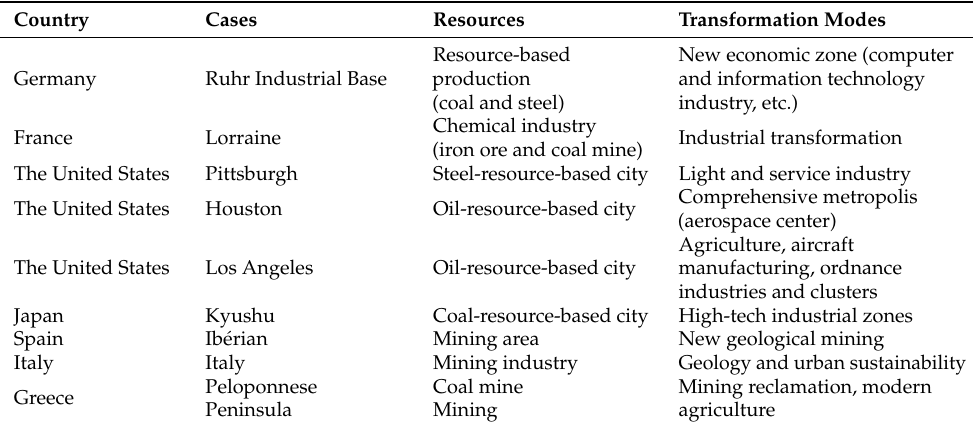
Table 1. Transformation cases of resource-exhausted cities.